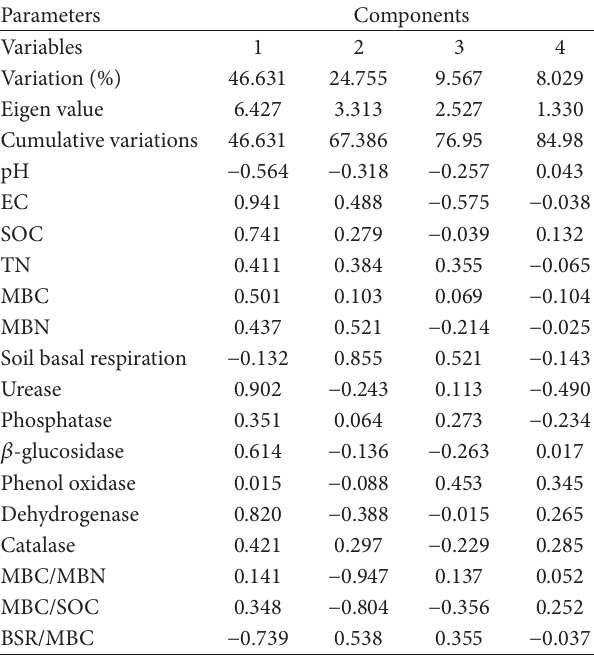
Table 2: Statistical significance analysis of the rhizosphere soil properties.